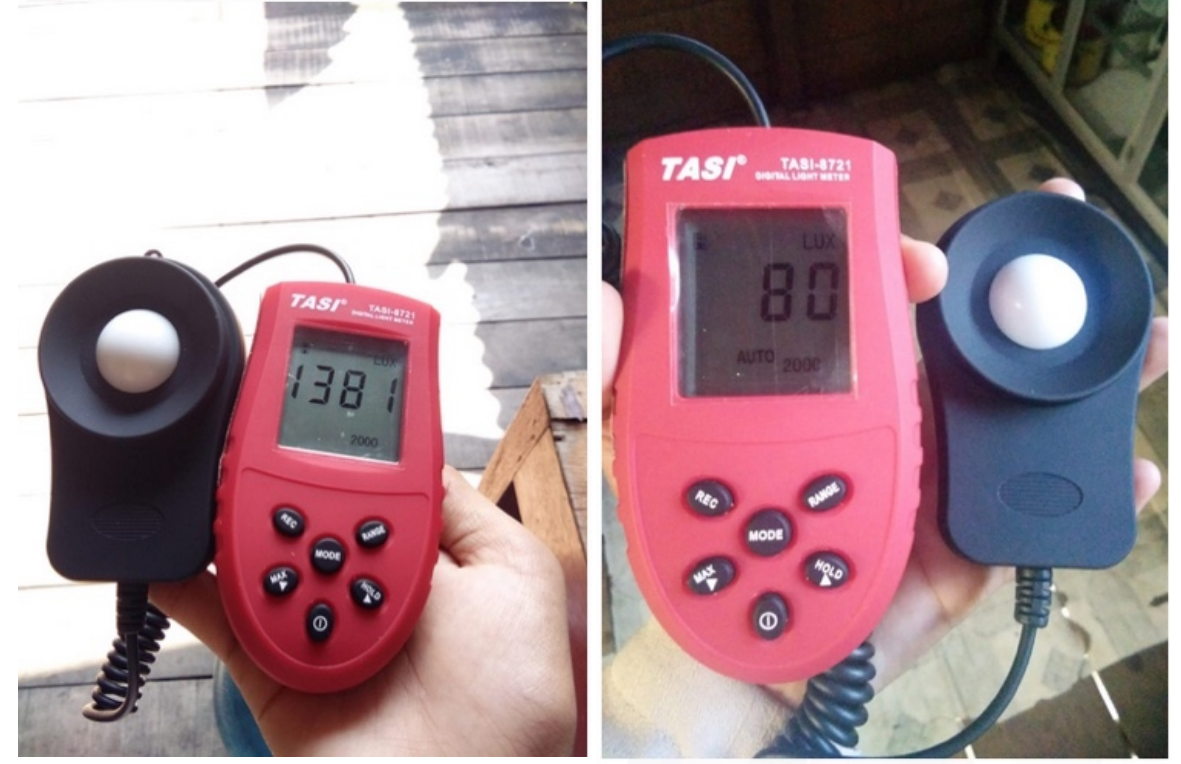
Fig. 2. Measuring